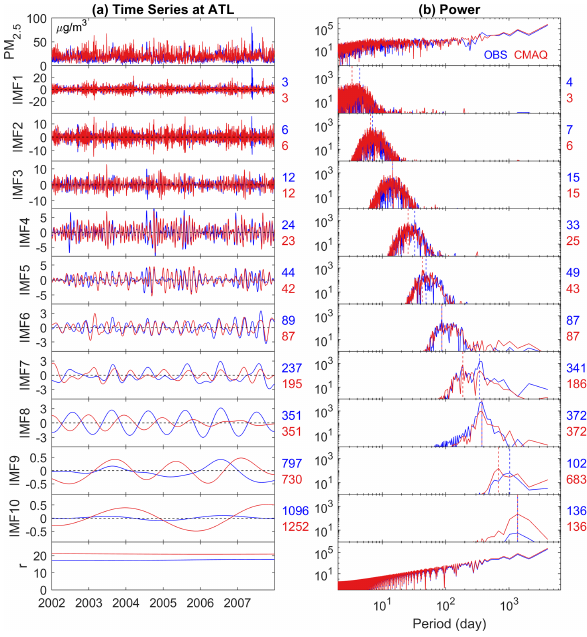
Figure 5. Same as Fig. 2 but for the ATL site with 10